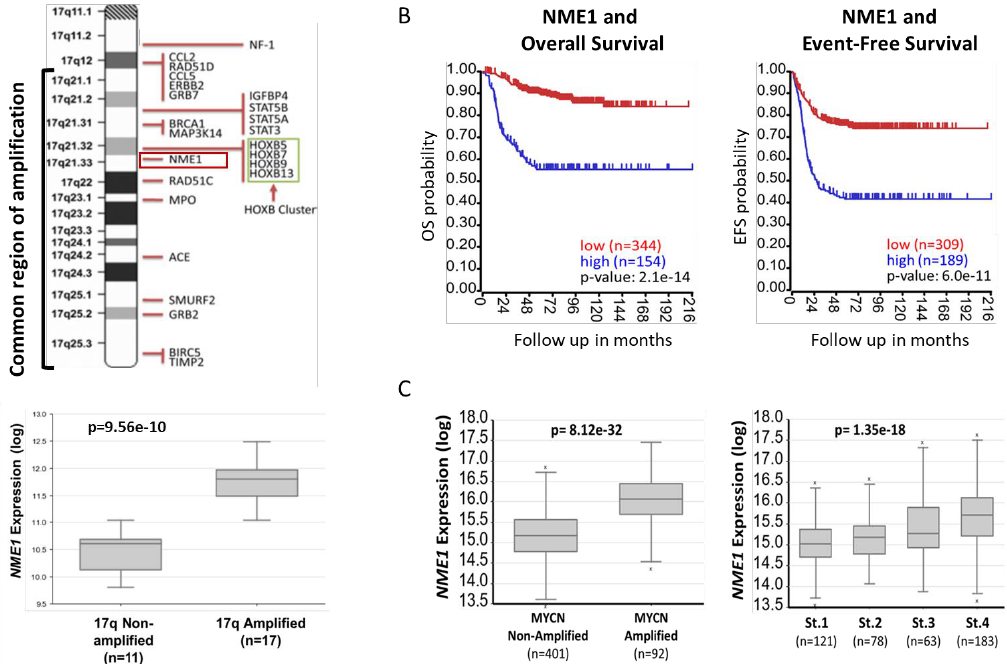
Figure 1. NME1 in neuroblastoma: ( A ) The chromosome 17q21 region amplified in neuroblastoma tumors is shown, with the NME1 gene located within the amplified region (top) [29]. Relative NME1 expression levels were plotted in patients with tumors with and without chromosome 17q amplification (bottom) using the neuroblastoma Lastowska patient dataset ( p value = 9.56e-10) in the R2 Genomics Analysis and Visualization Platform (http: // r2.amc.nl) [30]. ( B ) Using the SEQC patient dataset in the R2 Genomics Analysis and Visualization Platform, patients were divided into high (blue) and low (red) NME1 gene expression groups and survival curves were generated. Overall survival (OS; left) and event-free survival (EFS; right) are shown with respective p values of 2.1e-14 and 6.0e-11 and patient numbers in parentheses. ( C ) Relative NME1 expression levels from the SEQC patient dataset were plotted in patients with MYCN amplified and non-amplified tumors ( p value = 8.12e-32) and in patients with stage 1, 2, 3, and 4 tumors ( p value = 1.35e-18), respectively, with patient numbers shown in parentheses. The clinical characteristics of the 498 neuroblastoma patients included in Figure 1B,C are the following: Age ( < 18 months: 300 patients, > 18 months: 198 patients); Sex (278 males, 205 females and 15 N.A). For more information, the full details of this cohort have been previously published and are available through the R2 platform [31].